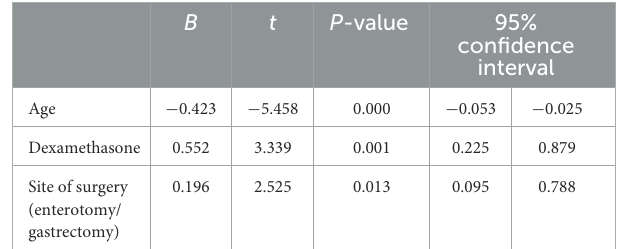
TABLE 6 Independent influencing factors of enteral nutrition caloric